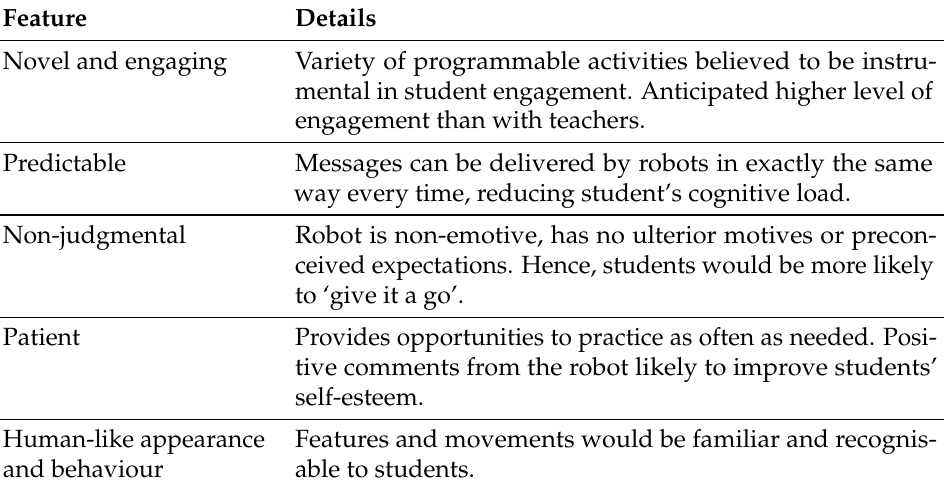
Table 5. Perceived enabling features of the